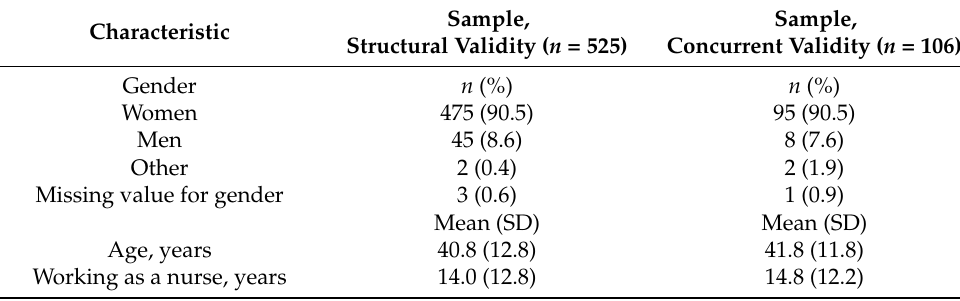
Table 1. Demographic characteristics of the